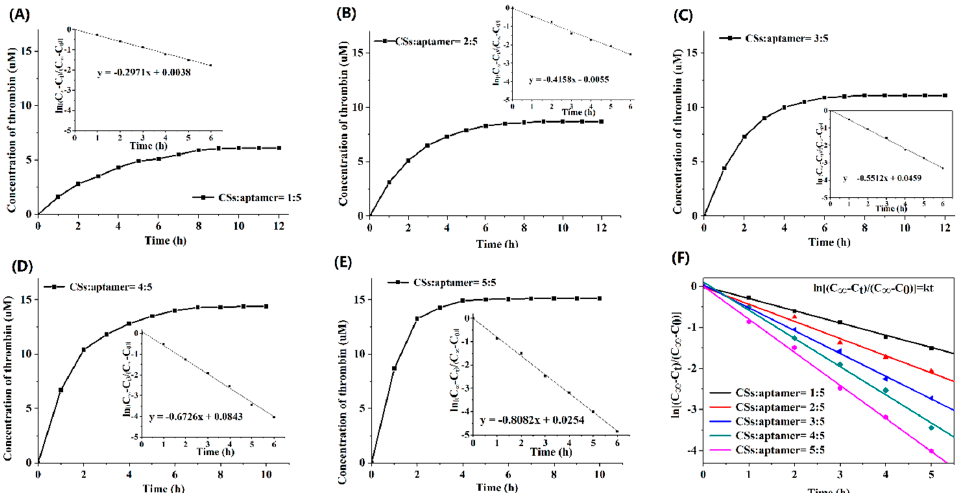
Figure 5. Dissociation dynamics of thrombin triggered by CS15 for different CSs to aptamer ratios: